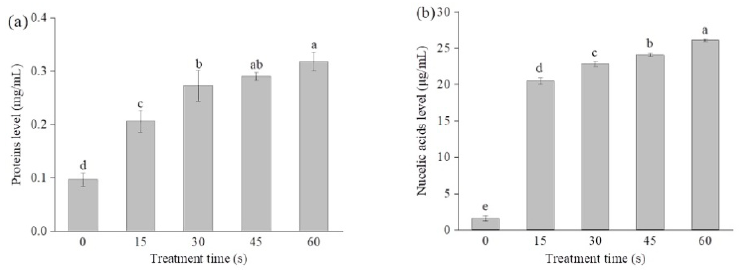
Figure 3. Leakages of intracellular proteins ( a ) and nucleic acids ( b ) changing with SAEW treatment in P. deceptionensis CM2 cells. Different letters above the bars indicate a statistically significant difference (LSD test, p < 0.05).